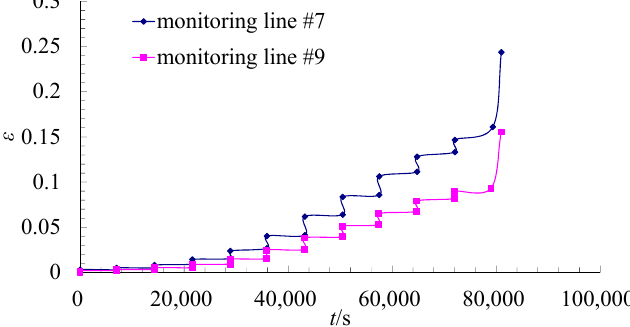
Figure 13. Displacement–time curves of monitoring lines #7 and #9.